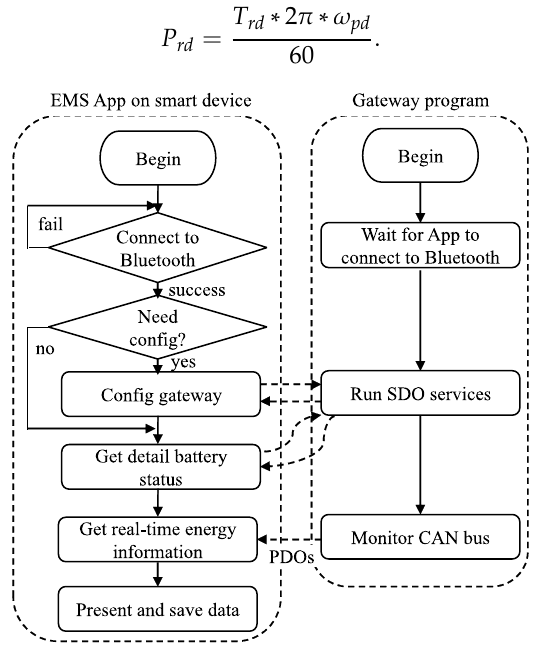
Figure 8. Operation flow of EMS.